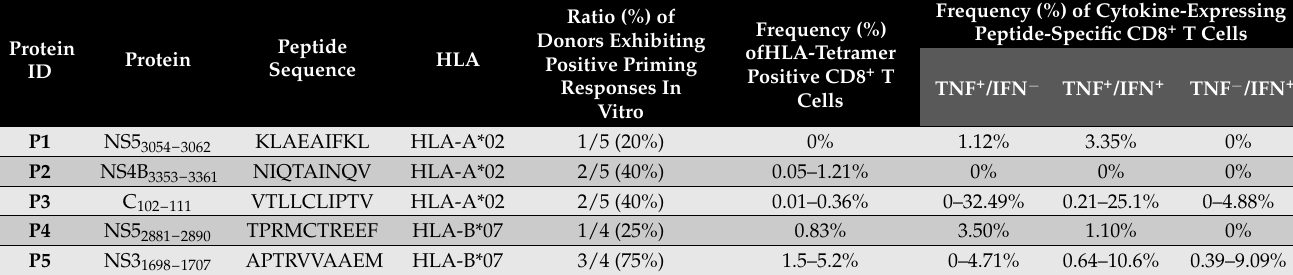
Figure 3. ORFV-DENV induces CD8 + T cells against several DENV-derived epitopes within the same individual in vitro. The responses of each donor are identified with different symbols and colors, as shown. Each symbol corresponds to a biological replicate exhibiting a positive response out of thirty (Donors 78, 27, and 25) or twenty (Donor 31) replicates. Effective priming was verified by ( A ) HLA tetramer staining and/or ( B ) ICS. Data for only four donors are shown. Cells from a fifth donor (data included in Table 2 only) showed a cytokine response to a pool of HLA-A*02-restricted DENV and control peptides; the specificity of the observed responses against individual peptides was not determined due to rapid cell death. CD8 + T cells from a sixth donor were not primed against any of DENV-derived or control epitopes (data not included). N/D, not determined (negative). Table 2. Summary of the results of DC-based in vitro priming of CD8+ T cells isolated from healthy blood